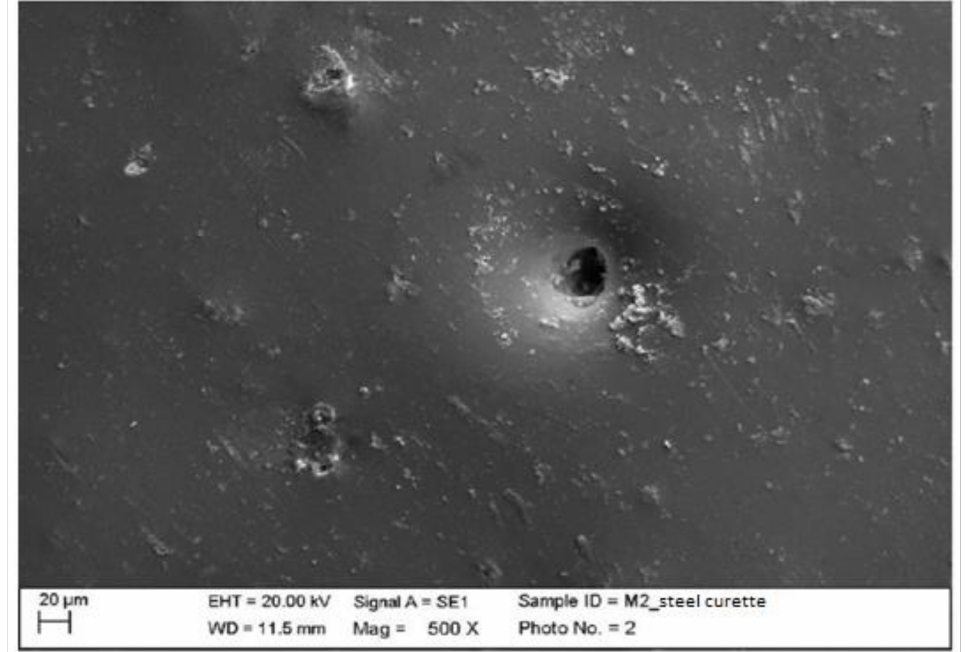
Figure 16. Instrumented ceramic sample M2 with steel curette (500 × ).